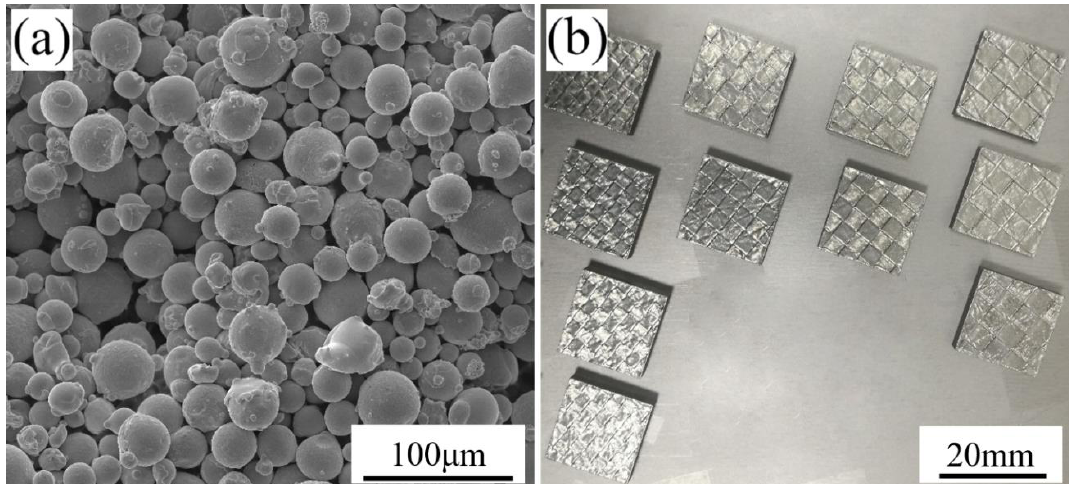
Figure 2. ( a ) Atomized René 104 Ni-based superalloy powder; ( b ) SLMed René 104 Ni-based superalloy samples. Table 1. Composition of atomized René 104 Ni-based superalloy powder (wt. %).